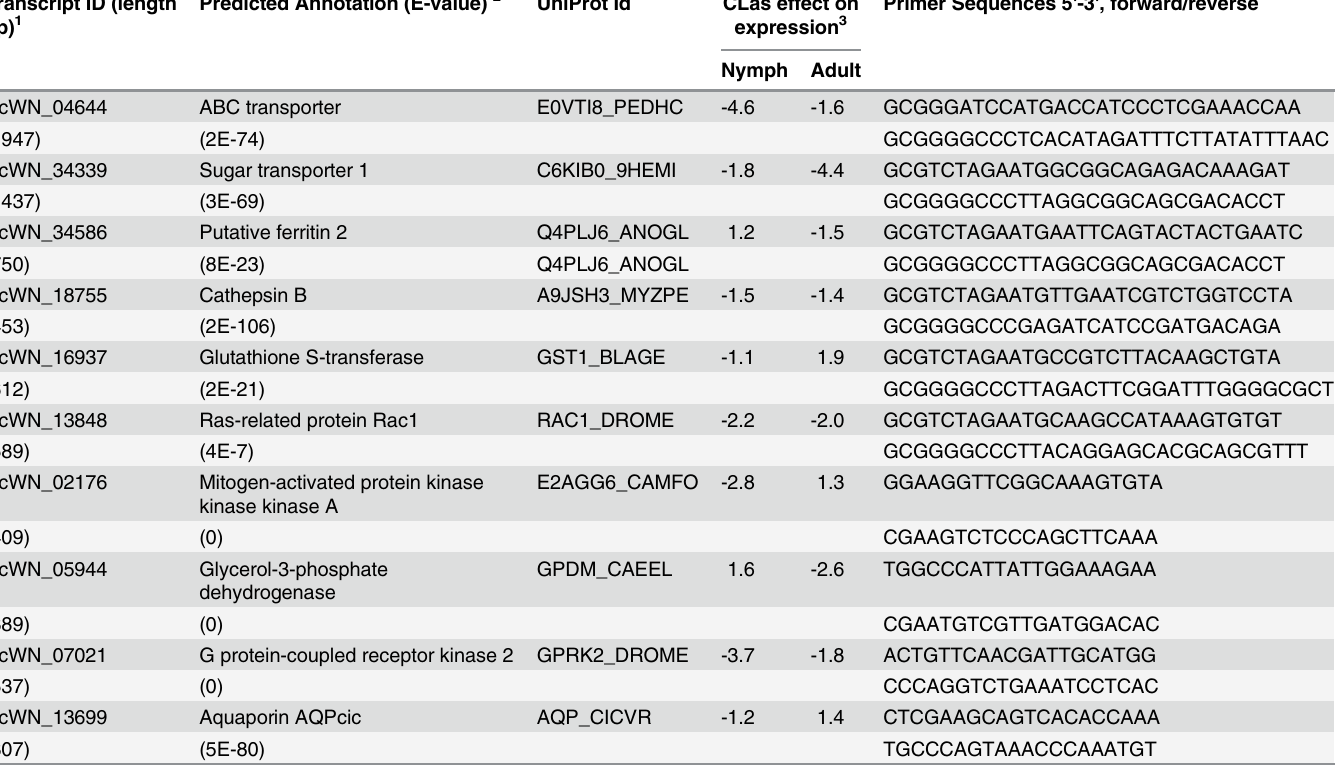
Table 3. RT-PCR results of 10 selected ACP transcripts usedselected subjected to validation by RT-PCR, cloning, and sequencing of RNA isolated from Ca . Liberibacter asiaticus-infected adult psyllids demonstrate the integrity of contigs in the